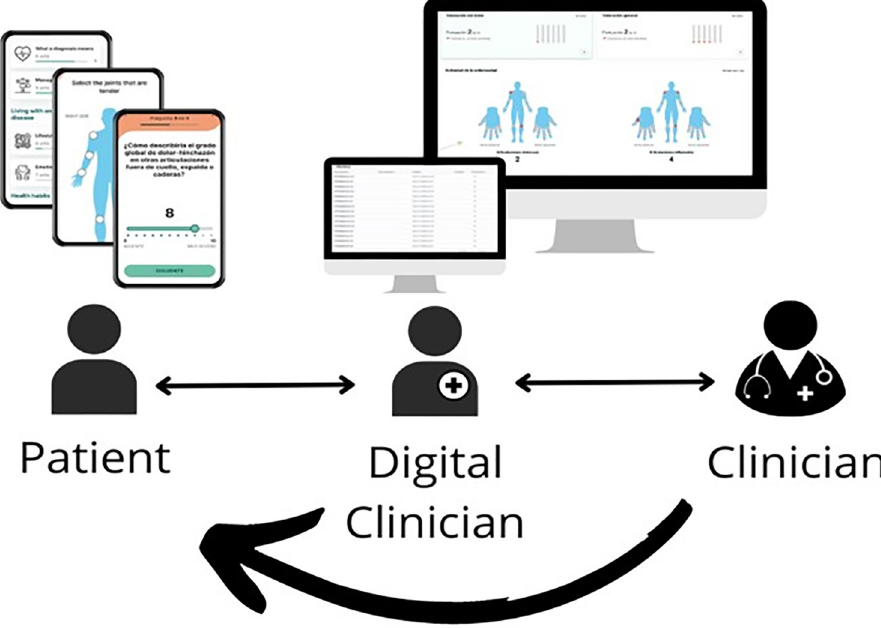
Fig 2. Digital monitoring in the study powered by Adhera for Rheumatology. Screenshots at top depict the mobile interface (left) and the clinical web application (right).